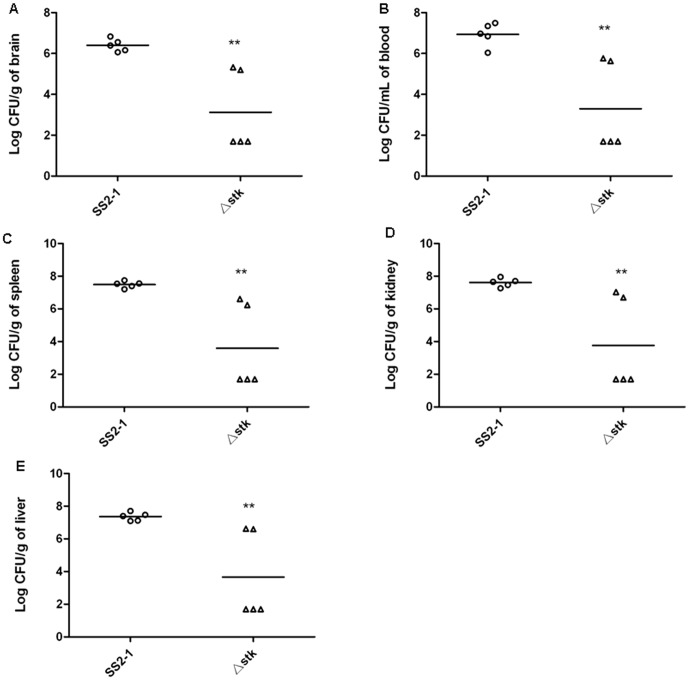
Bacterial viable in infected organs of mice(A:brain, B:blood, C:spleen, D:kidney, E:liver). Organ homogenates in which bacteria were not detected were arbitrarily assigned a value of 50 CFU, corresponding to the lower limit of the assay. Data were means ± SD of bacterial colonies from five mice.(**p<0.01).